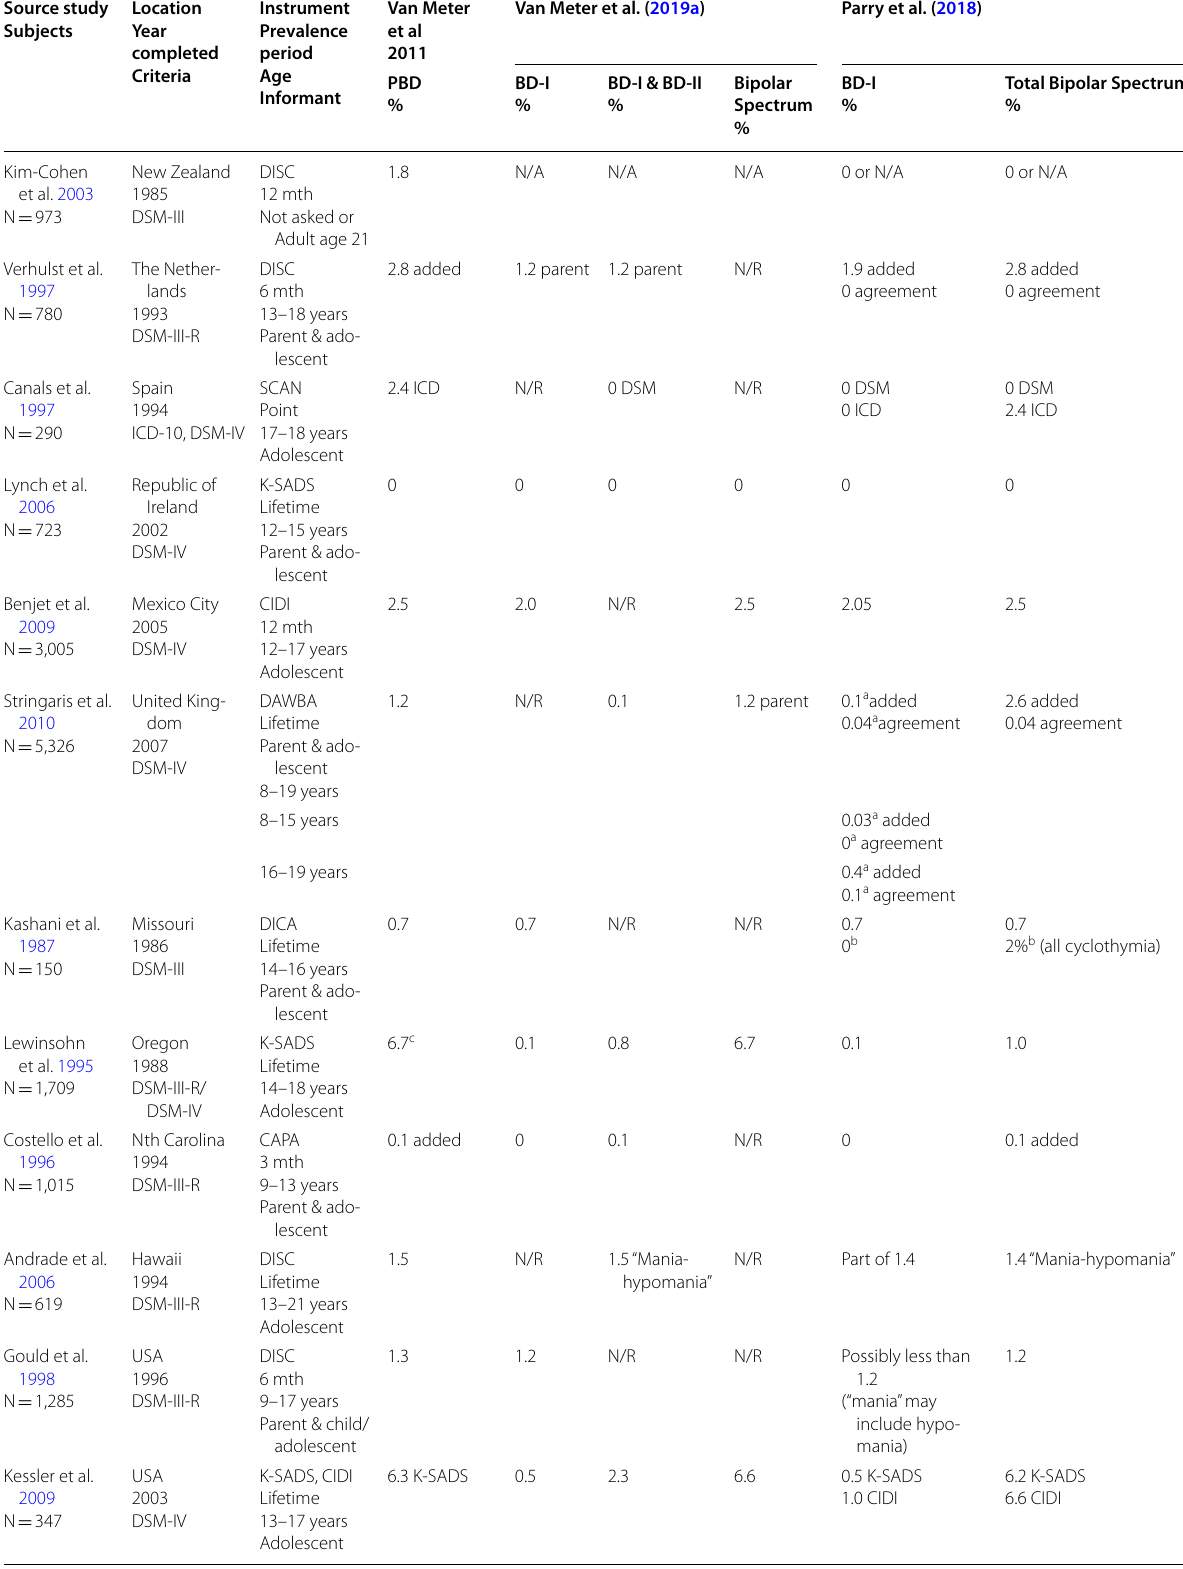
Table 1 The original 12 epidemiological studies reported by Van Meter et al.